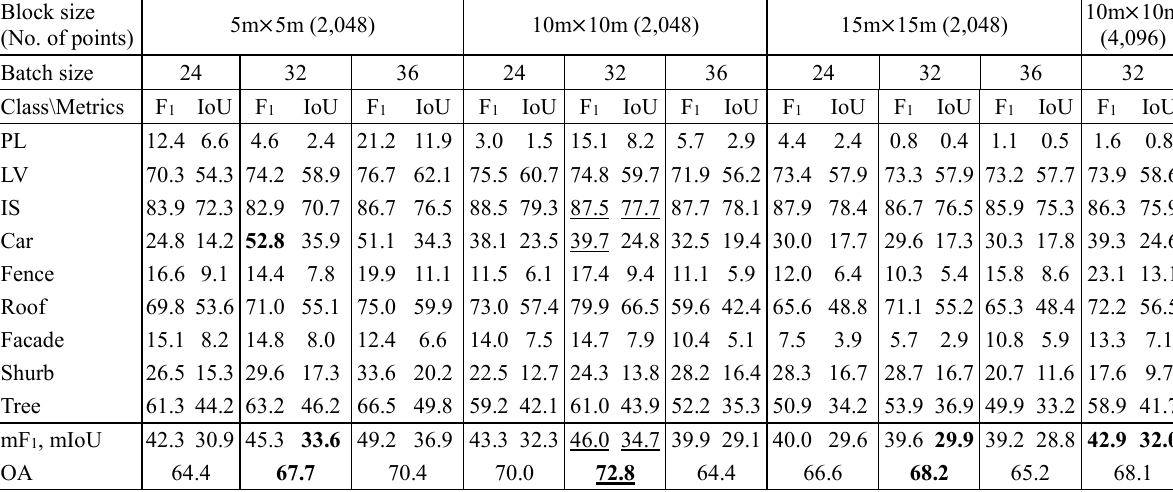
Table 1. PointNet performance metrics for the Vaihingen test dataset (values are in